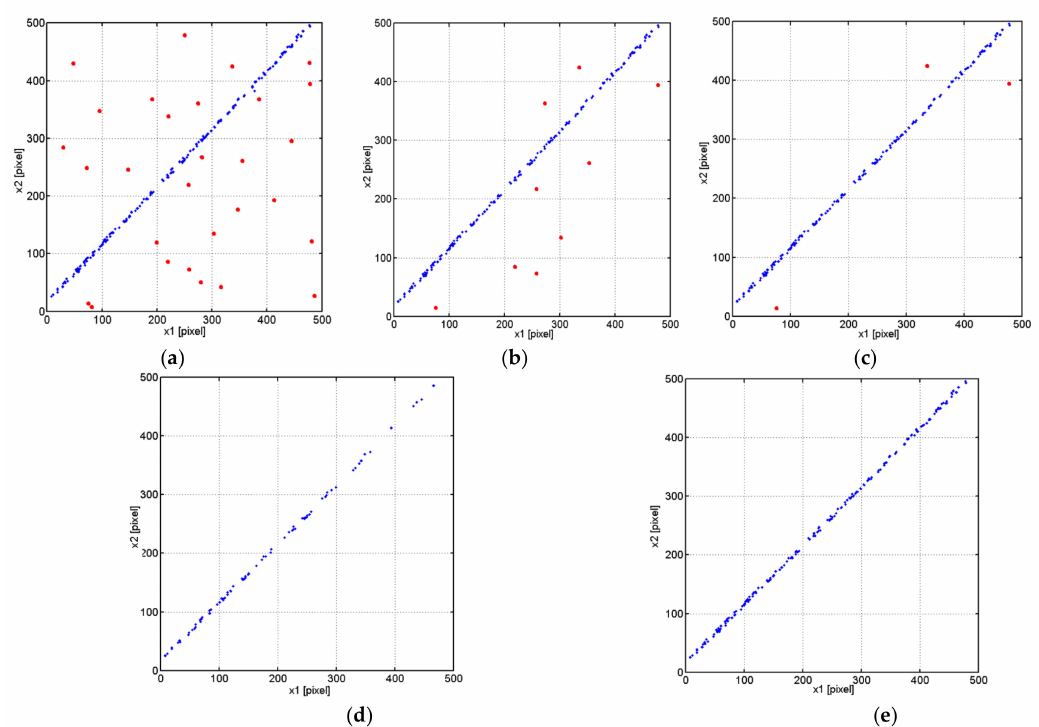
Figure 9. Comparing the performance of the outlier removal with the horizontal displacements by di ff erent methods for case 2. The x-axis represents the simulated start position × 1, and the y-axis represents the end position × 2. ( a ) Original image. ( b ) Result of ( µ − 3 σ , µ + 3 σ ). ( c ) Result of ( µ − 2 σ , µ + 2 σ ). ( d ) Result of ( µ − σ , µ + σ ) ( e ). Result of Random Sample Consensus (RANSAC). Red points are identified as